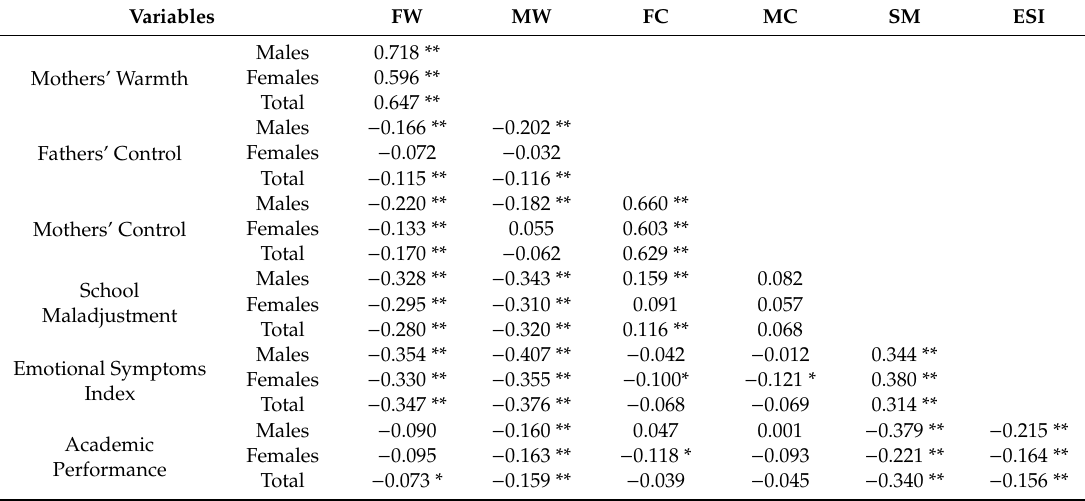
Table 2. Correlations for males, females, and total sample with study